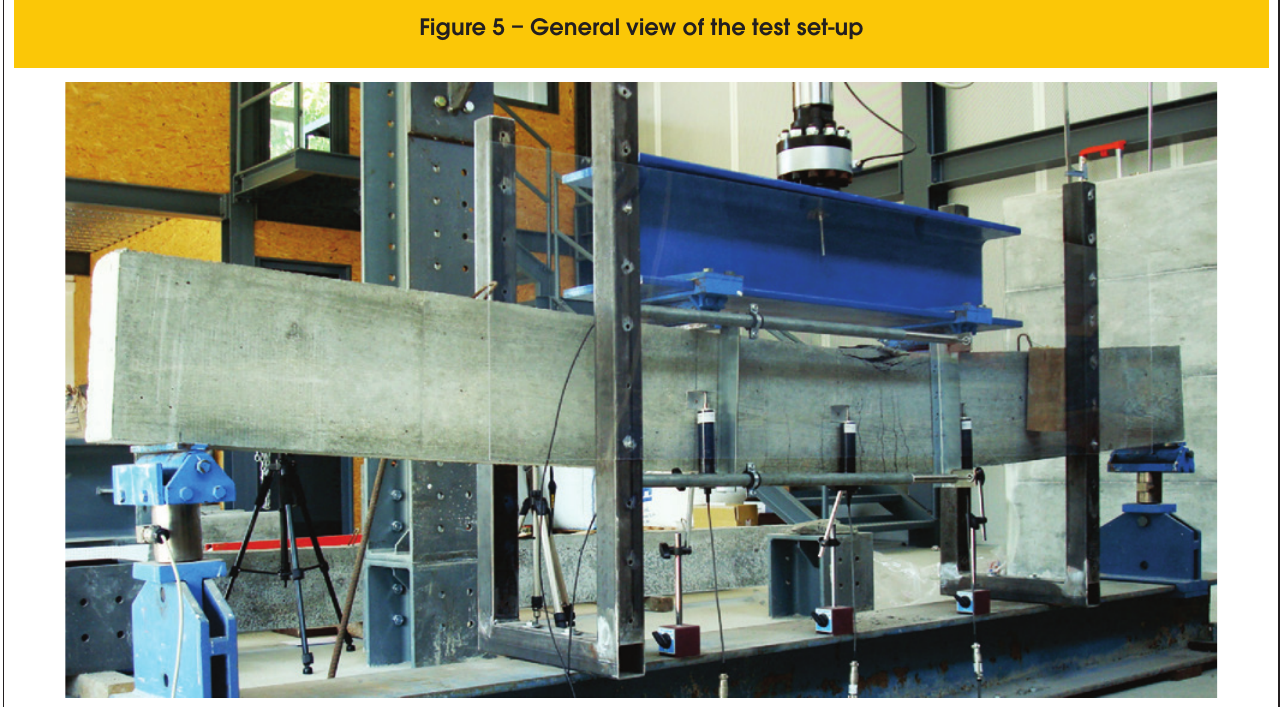
Figure 5 – General view of the test